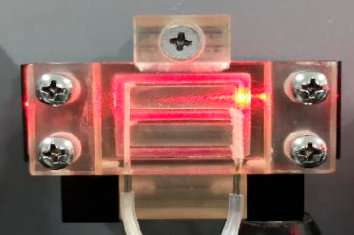
Figure 2. Section analysis of glass substrate ( a ), CV-SiO 2 gel film ( b ), and SiO 2 gel film ( c ).